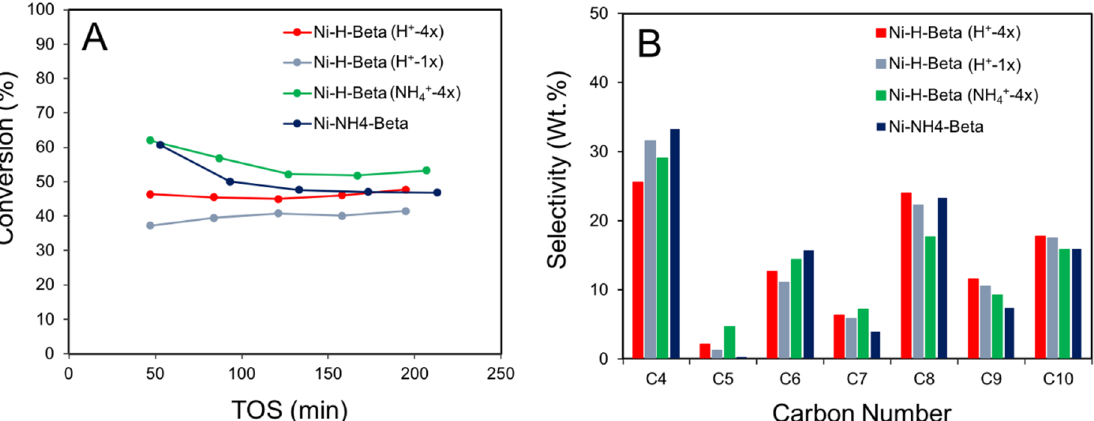
Figure 10. EO over Ni-H-Beta catalysts after in situ pretreatment at 300 °C in N 2 . T = 225 °C, P = 11 bar, WHSV = 3 h − 1 : ( A ) Conversion with time on stream (TOS) and ( B ) steady-state oligomer distribution.